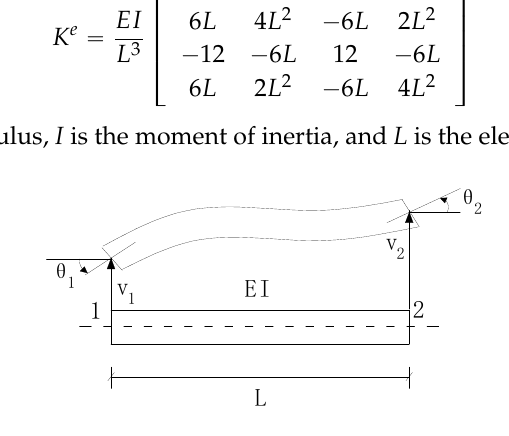
Figure 1. A Bernoulli-Euler plane beam element